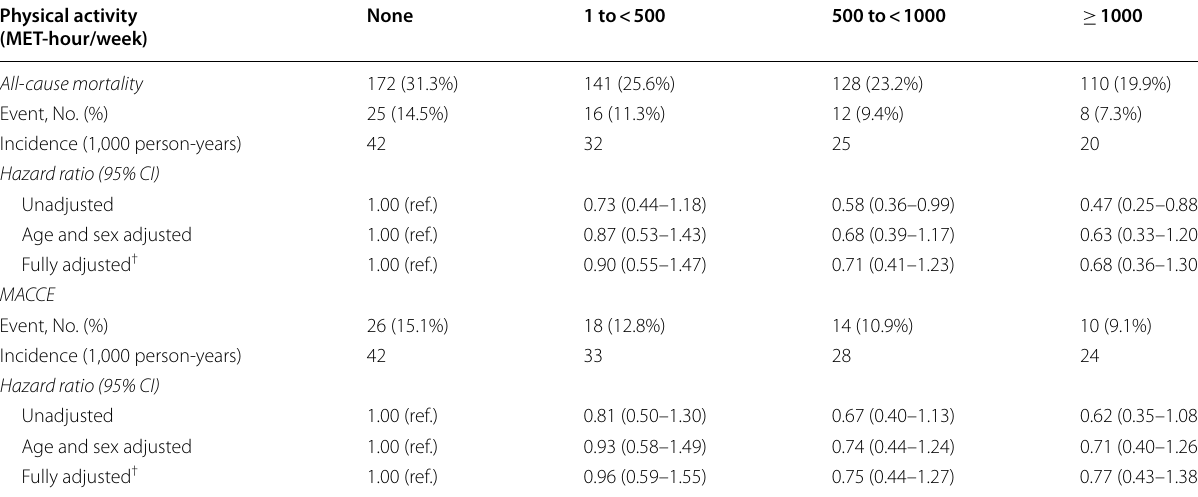
† Multivariable adjusted hazard ratio: age, sex, body mass index, heart failure, hypertension, diabetes, previous myocardial infarction, prior stroke or transient ischemic attack, chronic kidney disease, dyslipidemia, smoking, and alcohol intake CI confidence interval, MACCE major adverse cardiac and cerebrovascular event, MET metabolic equivalent task